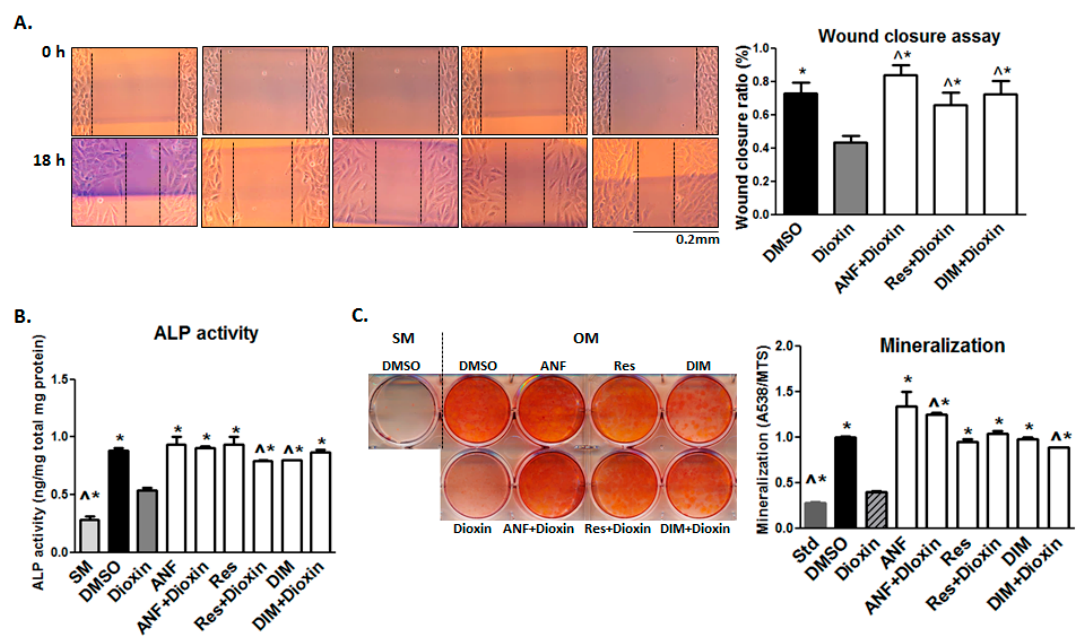
Figure 7. Effect of AhR antagonist co-treatment on cell migration and osteogenic differentiation. AhR antagonist co-treatment mitigated the effects of dioxin on cell migration and osteogenic differentiation. ( A ) In a wound healing chamber assay, co-treatment with ANF, resveratrol, and DIM significantly increased cell migration across a wound space compared to MG-63 cells treated with dioxin alone; ( B , C ) A similar mitigating effect from antagonist co-treatment was also observed for ALP activity and mineralization deposition. ^ p < 0.05, significance relative 0 nM dioxin (i.e., DMSO control) under osteogenic conditions, * p < 0.05, significance relative 100 nM dioxin under osteogenic conditions ( A – C ). Error bar means ± SEM.